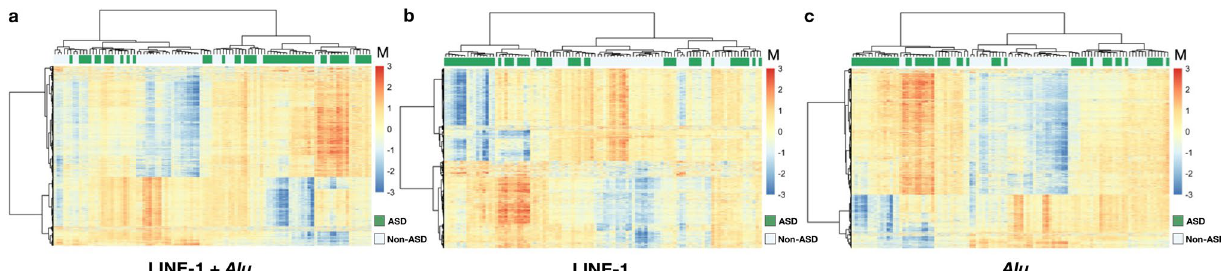
Figure 2. Unsupervised hierarchical cluster heatmap of the significant differentially methylated loci of the repetitive elements in non-ASD and ASD. Clustering of the 7165 significant differentially methylated loci (combining of LINE-1 and Alu loci) ( a ). Clustering of the 2802 significant differentially methylated loci (LINE-1) ( b ). Clustering of the 4363 significant differentially methylated loci ( Alu ) ( c ). The color scale indicates methylation level (M value), from low (blue) to high (red). Green color represents ASD and white color represents